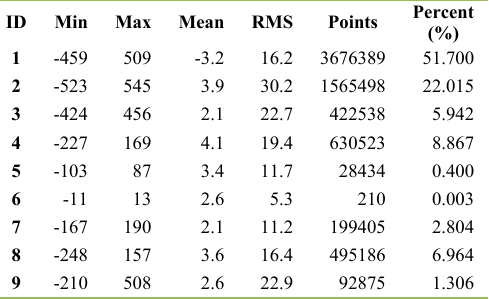
Table 4. Statistics of the elevation difference between ASTER GDEM2 and CSI SRTM separating into Globcover land cover classes. Unit is